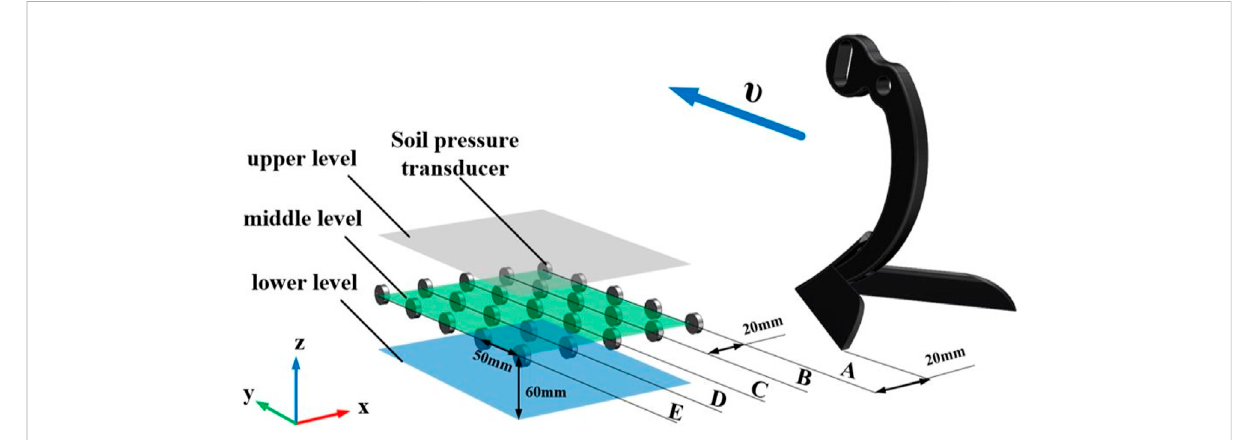
FIGURE 5 Schematic of the experimental set-up (v: velocity vector of